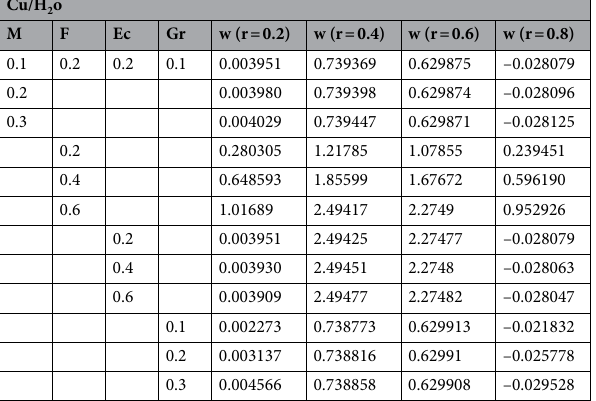
Table 3. Results for velocity profile against nondimensional parameters.